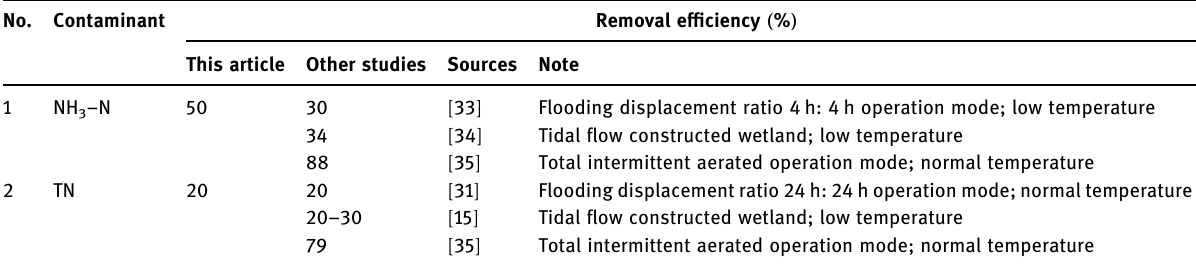
Table 4: Comparison of main nitrogen elements with other related research results No.